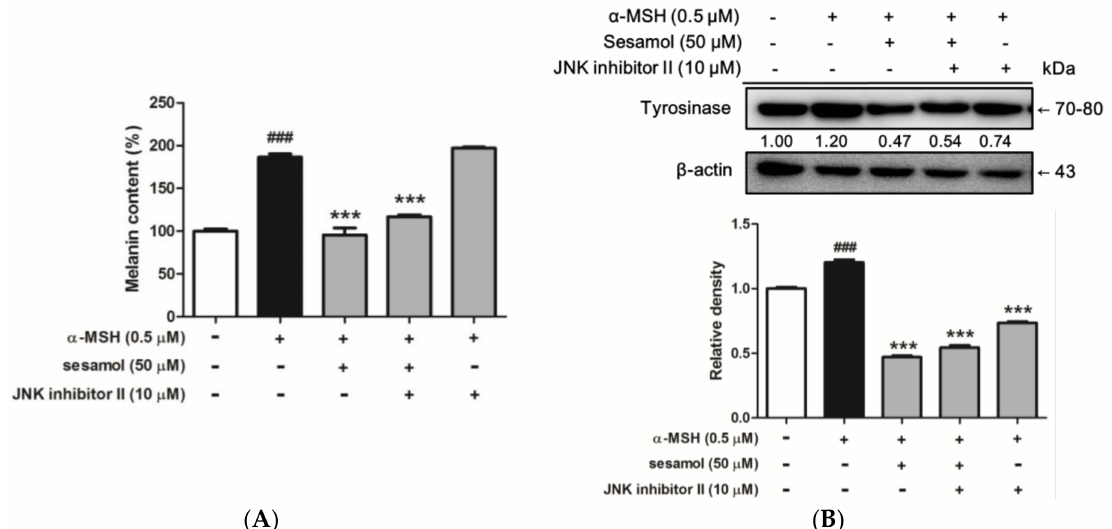
Figure 10. ( A ) Effect of sesamol and JNK inhibitor II on melanin content (%) in α -MSH-treated B16F10 cells after 48 h. Each value is presented as the mean ± SD. ### p < 0.001 (Significant difference versus control); *** p < 0.001 (Significant difference versus α -MSH treated group). ( B ) Effects of sesamol and JNK inhibitor II on protein expression of tyrosinase in α -MSH-treated B16F10 cells after 48 h. Each value is presented as the mean ± SD. ### p < 0.001 (Significant difference versus control); *** p < 0.001 (Significant difference versus α -MSH treated